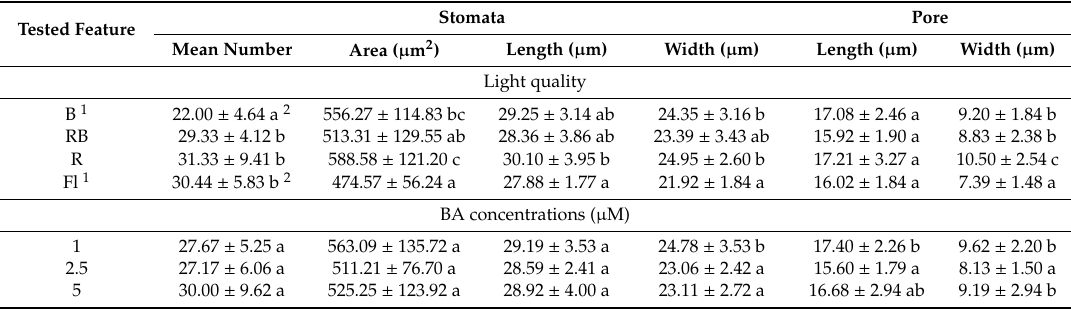
Table 2. Characteristics of the stomata in gerbera leaves after 6 weeks of in vitro cultivation of shoots depending on the quality of light and the concentration of BA in the